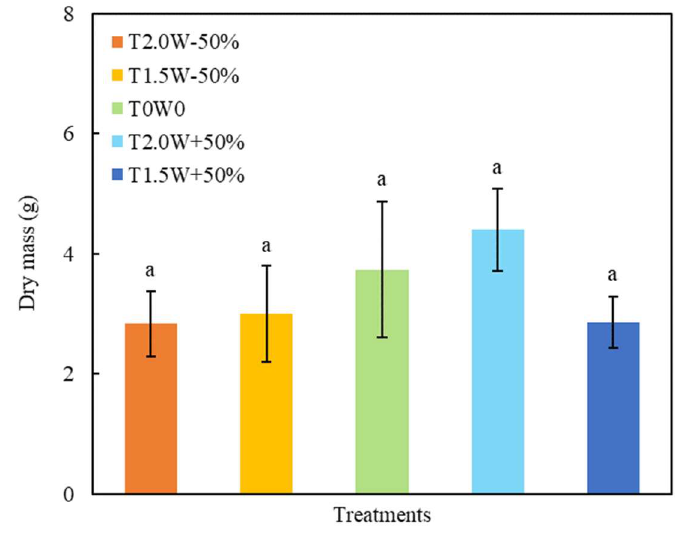
Figure 3. Effects of temperature and precipitation treatments on dry mass (means ± SE). The letter “a” in the figure was used to indicate significant differences among treatments ( p < 0.05).